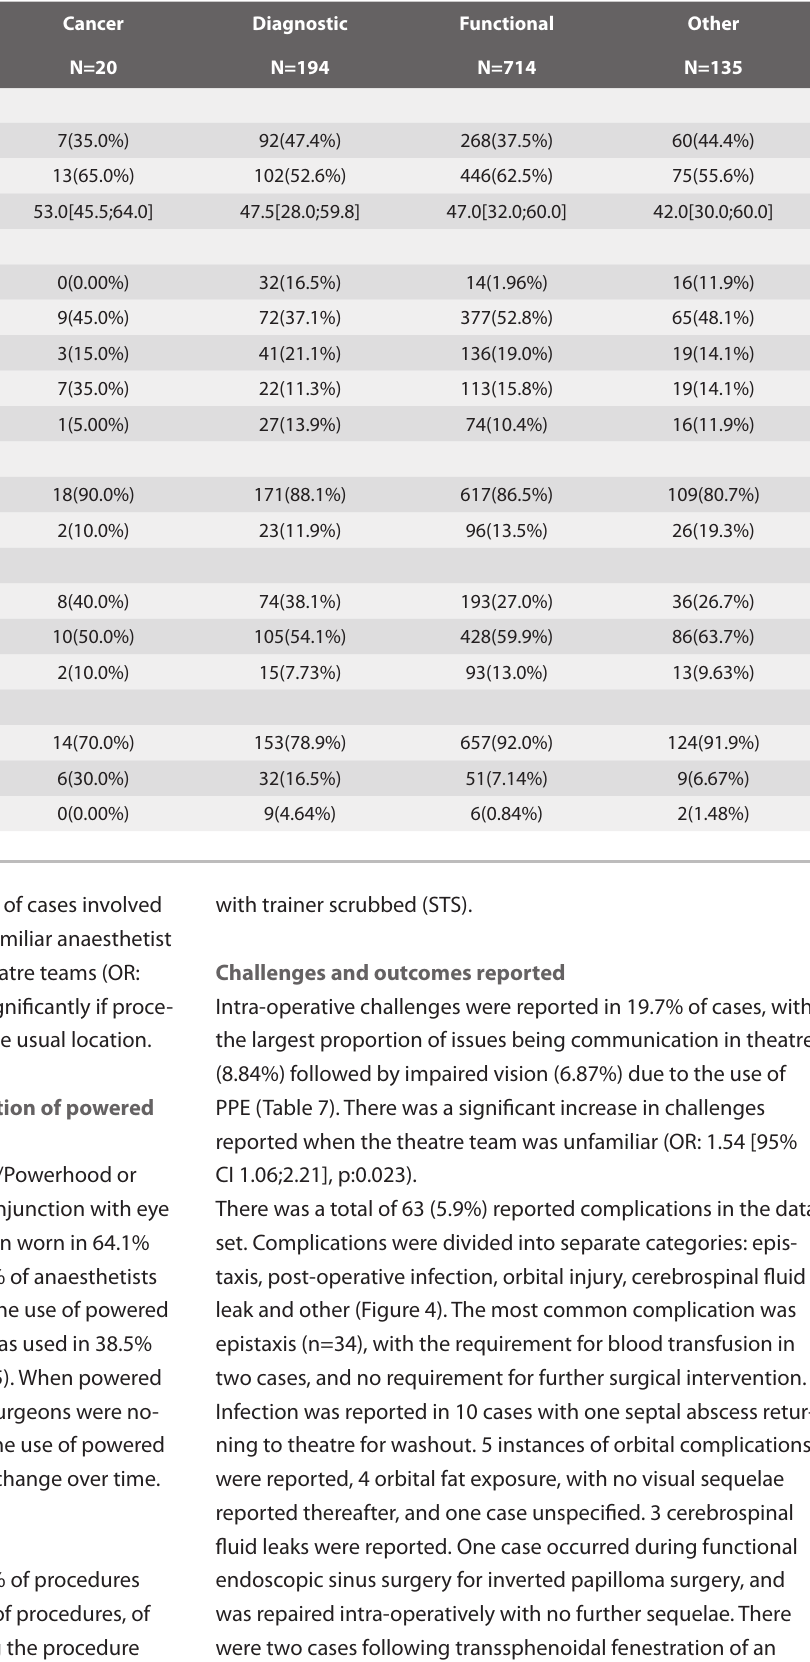
Table 1. Basic demographics.